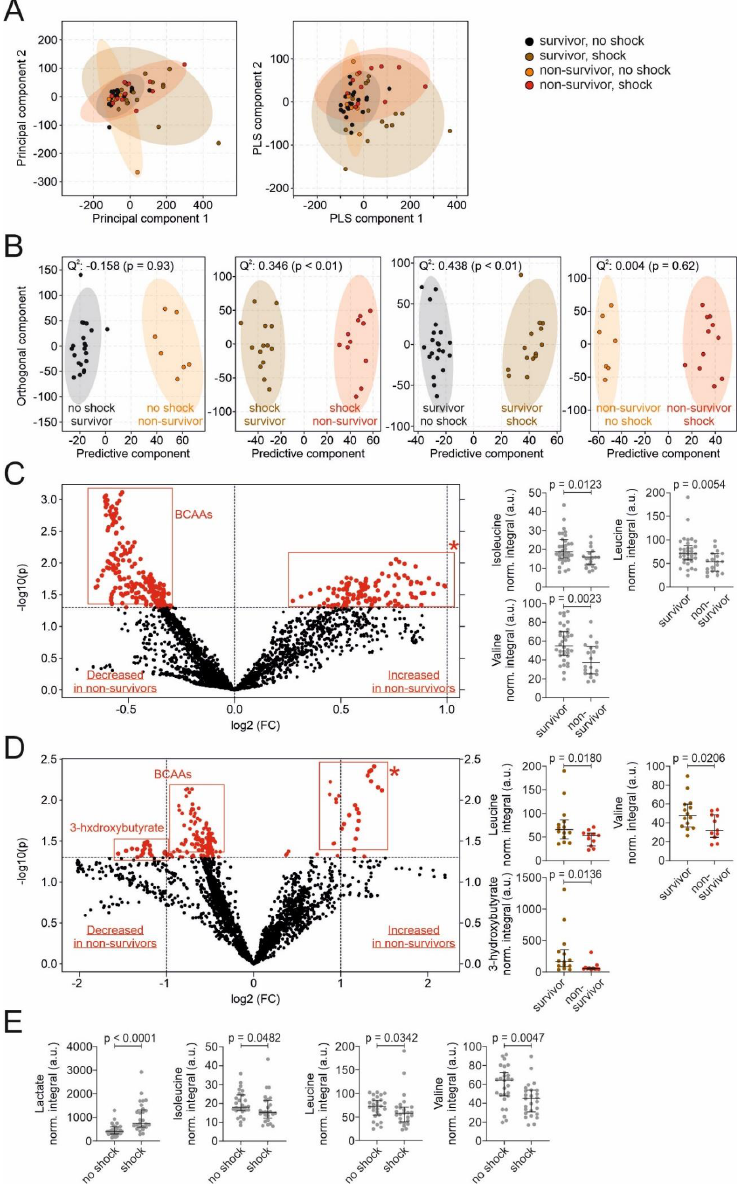
Figure 2. Untargeted metabolomic assessment of metabolites in sepsis. ( A ) Principal component analysis (PCA; left panel) and partial least squares discriminant analysis (PLS-DA; right panel) for the differentiation between the four groups of survivors and non-survivors, each for the shock and no-shock group. PCA: principal component (PC) 1 of 55% and PC2 of 14.3%. PLS-DA: Component 1 of 50.4%, Component 2 of 14.6%. ( B ) Pair-wise orthogonal partial least squares discriminant analysis (O-PLS-DA) showing acceptable clustering for survivors and non-survivor in the shock group (middle-left panel; Q 2 = 0.346, p < 0.01), as well as survivors of the no-shock and shock group (middle-right panel; Q 2 = 0.438, p < 0.01). No significant clustering was found for survivors and non-survivor in the no-shock group (left panel; p = 0.93) and for non-survivors of the no-shock and shock group (right panel; p = 0.62). ( C ) Differences in metabolites of all sepsis patients between survivors and non-survivors (volcano plot). The horizontal dashed line marks the level of significance at 0.05. The boxplots represent the most pronounced and most significant different metabolites. ( D ) Differences in metabolites of septic shock patients between survivors and non-survivors (volcano plot). The horizontal dashed line marks the level of significance at 0.05. The boxplots represent the most pronounced and most significant different metabolites. ( E ) Comparison between no-shock and septic shock patients. Boxplots of the most pronounced and most significant different metabolites. Abbreviations: BCAA = branched-chain amino acids (consisting of valine, leucine, and isoleucine). a.u. = arbitrary unit. * = unassigned